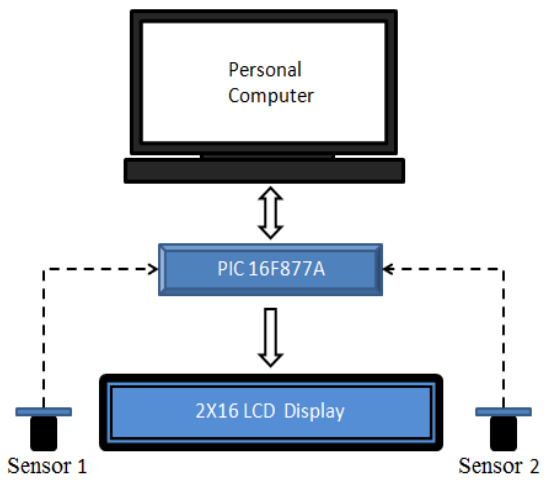
Figure 3: System